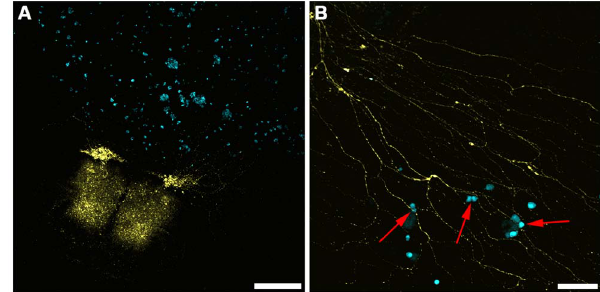
Figure 2. Representative confocal images from novel exvivo organotypic spinal cord slice and co-culture model with C4- 2B4 cells. A . Tile scan where YFP spinal cord is clearly positive as well as outgrowth of neurons with multiple nodal appearance (scale bar = 500 m m) B . Higher magnification image of neuronal outgrowths from A . In this image C4-2B cells appear to associate with YFP + nerve axons (red arrows, scale bar = 100 m m).